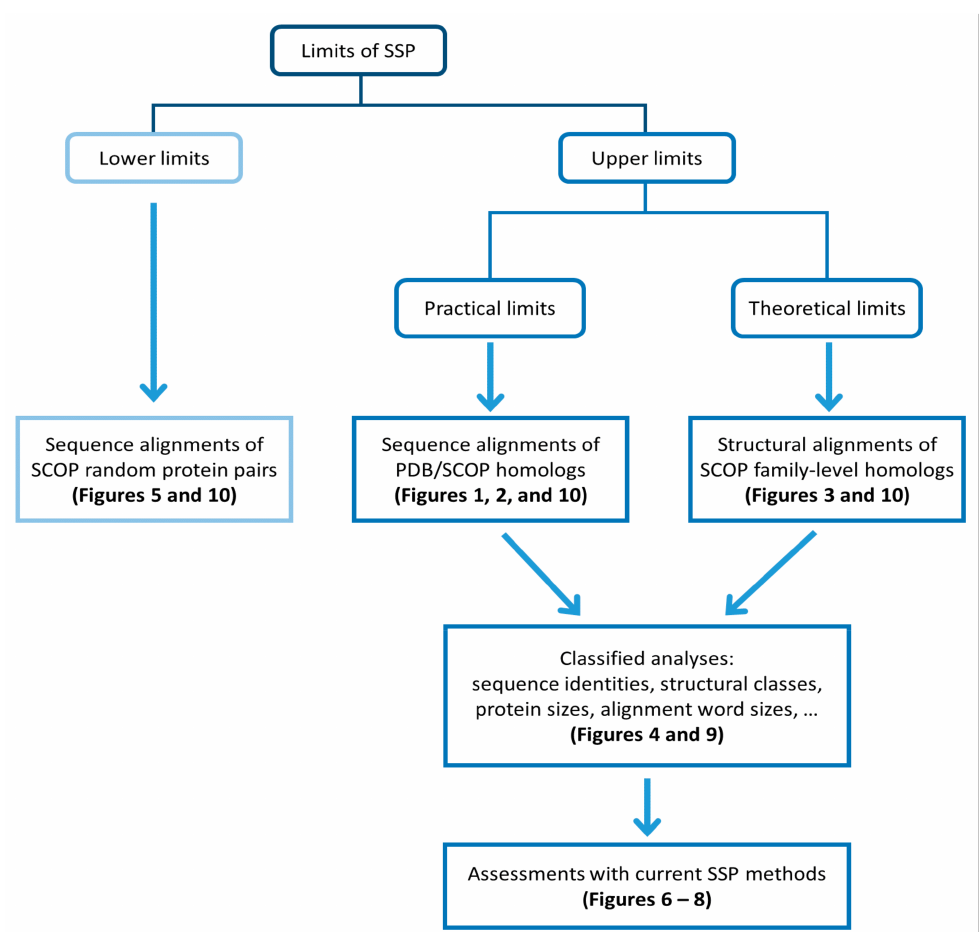
Figure A1. A general schema of the methodology. Sequence and structural alignments between protein structural homologs were performed to estimate the upper limits of SSP accuracy, while random pairing between protein structures was conducted to draw the lower bound of SSP. Note that only aligned residues were considered in estimating SSP limits. The effects of disordered regions, which were likely presented in the unaligned segments, might thus be